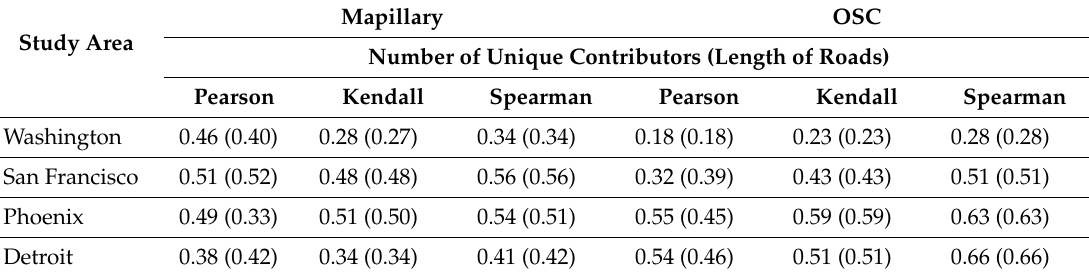
Figure 5. Normalized population density per 1 × 1 km road lengths. Table 4. Correlation between the number of contributors and length of roads (denoted in parentheses) with population density per 1 × 1 km grid area. All correlation values were found to be significant at the 0.01 (i.e., 99%) level.